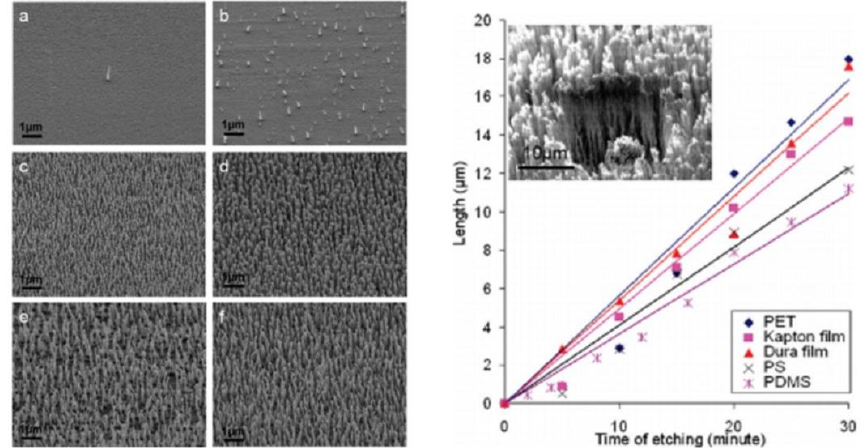
Figure 8. SEM images of the density-controlled fabrication of polymer nanowire (NW) arrays of Kapton by covering the initial surface with ( a ) 0.75; ( b ) 1.5; ( c ) 3; ( d ) 4.5; ( e ) 10; and ( f ) 15 nm of Au before inductively coupled plasma (ICP) etching. The graph represents the length-controlled growth of NWs of polyethylene terephthalate (PET), Kapton film, Durafilm, polystyrene (PS), and polydimethyl siloxane (PDMS). The inset is a SEM image of a NW array on Durafilm after 30 min of etching (Reproduced with permission from [128]. Copyright American Chemical Society, 2009).